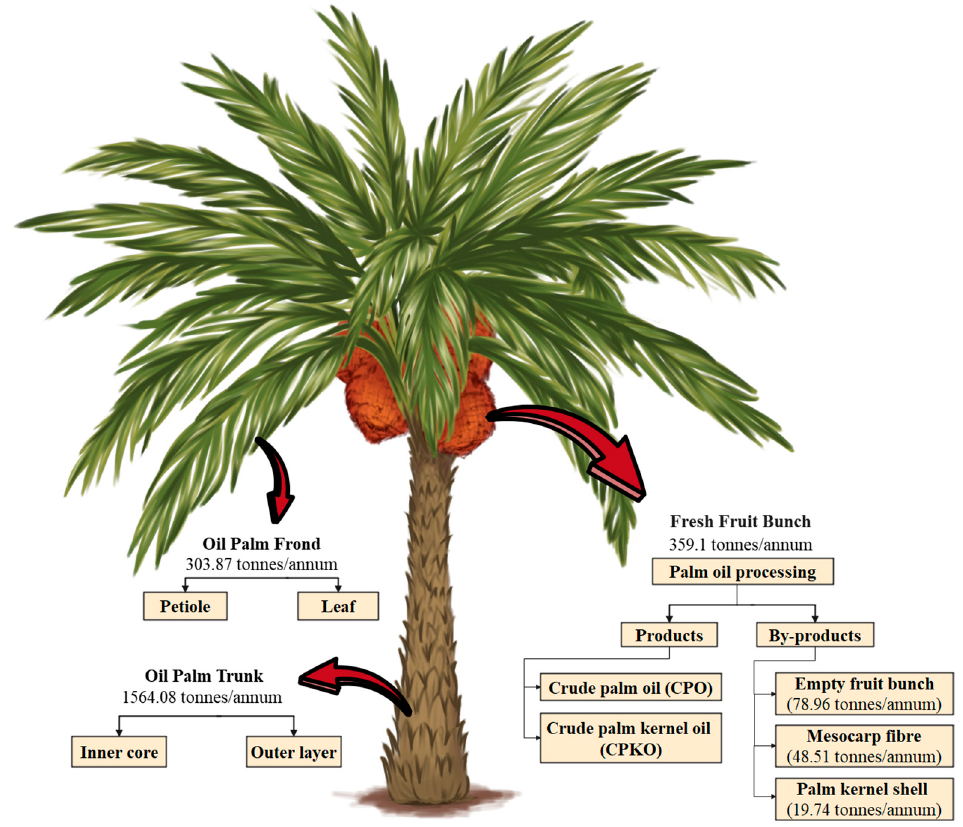
Figure 2. The anatomy of oil palm tree with the global amount of biomass generated. Table 1. Amount of oil palm biomass